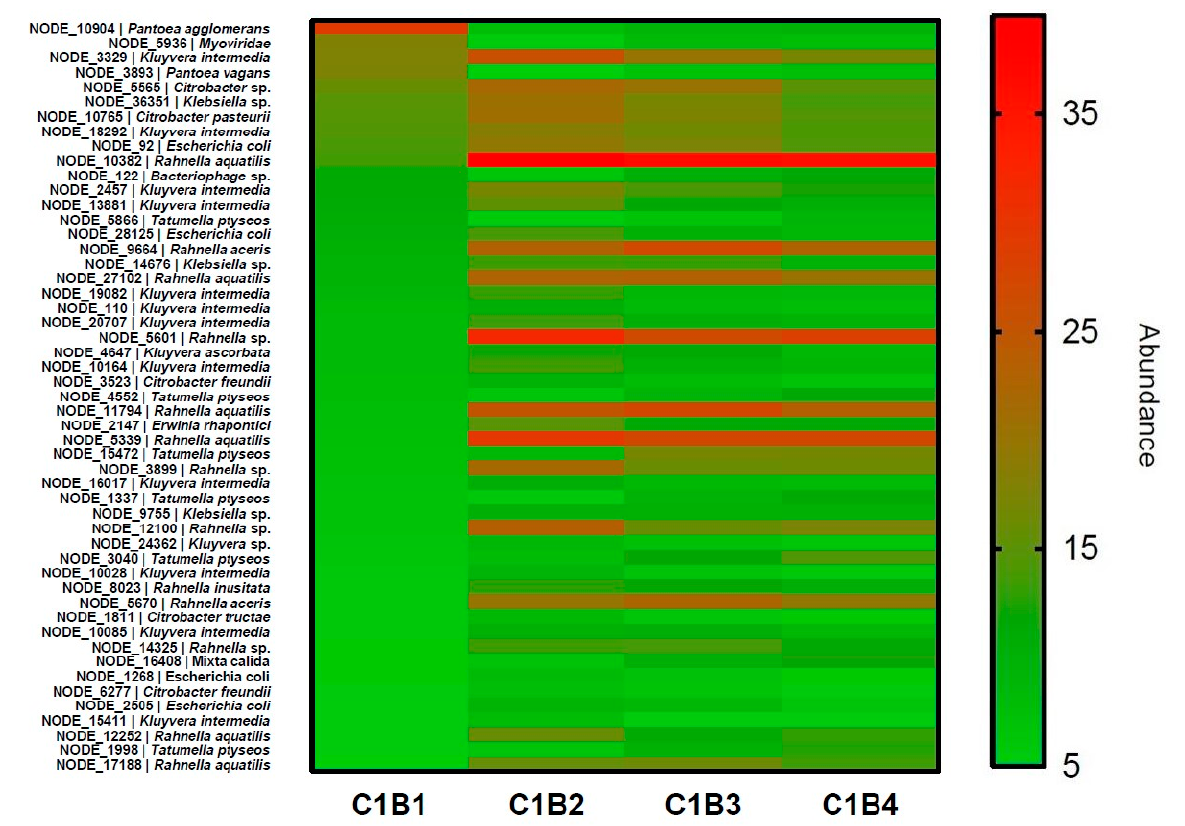
Figure 1. Heatmap showing the dynamics of the most abundant prophages retrieved during the first month of the fermentation process for producer B. C1 indicates the tank ID, and B1, B2, B3 and B4 are the sampling points during the fermentation process, in reference to Table 1. NODE referred to the identified prophage and the mentioned bacterial identifications represent the best host species of the prophage predicted after blast (E-value < 10 − 16 ; % of identity >85%). RPKM value above 5.0 was considered for the construction of the heatmap. Green to red: lowest to highest abundance.